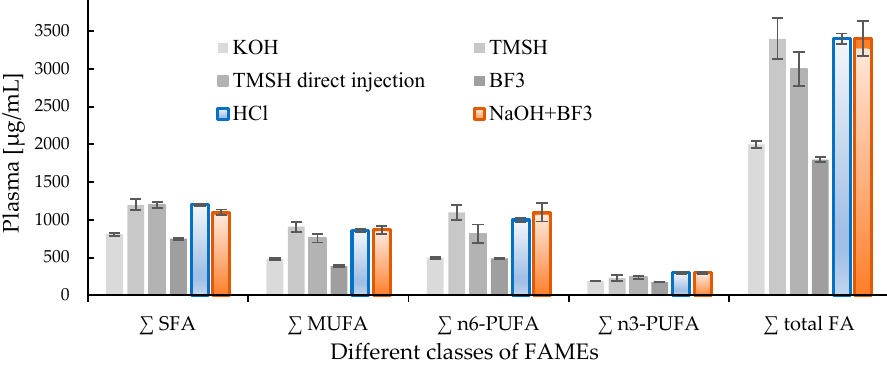
Figure 1. Comparison of derivatization efficacy of different derivatization methods [7].